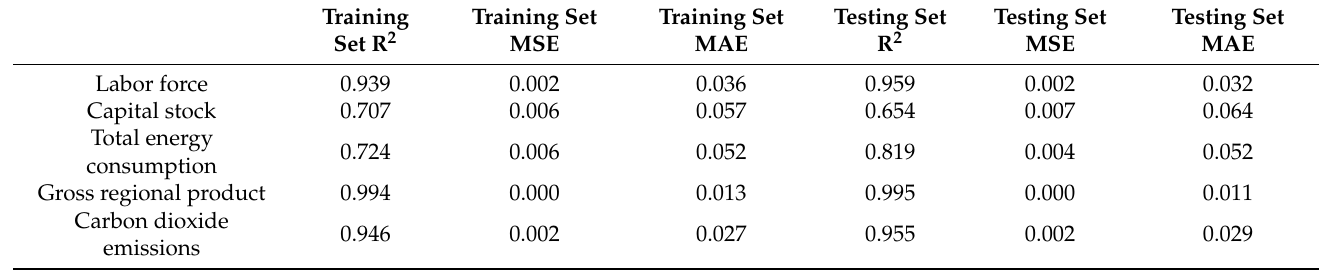
Table 5. Evaluation index data of the fitting effect of each input–output index.